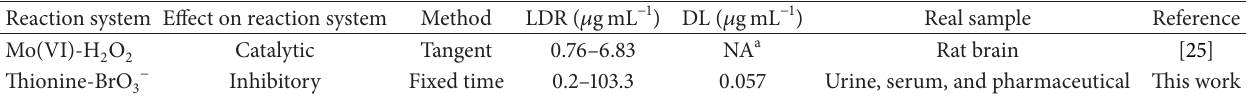
Table 1: Comparison of some analytical characteristic of reported catalytic spectrophotometric method to the proposed method for the determination of dopamine.